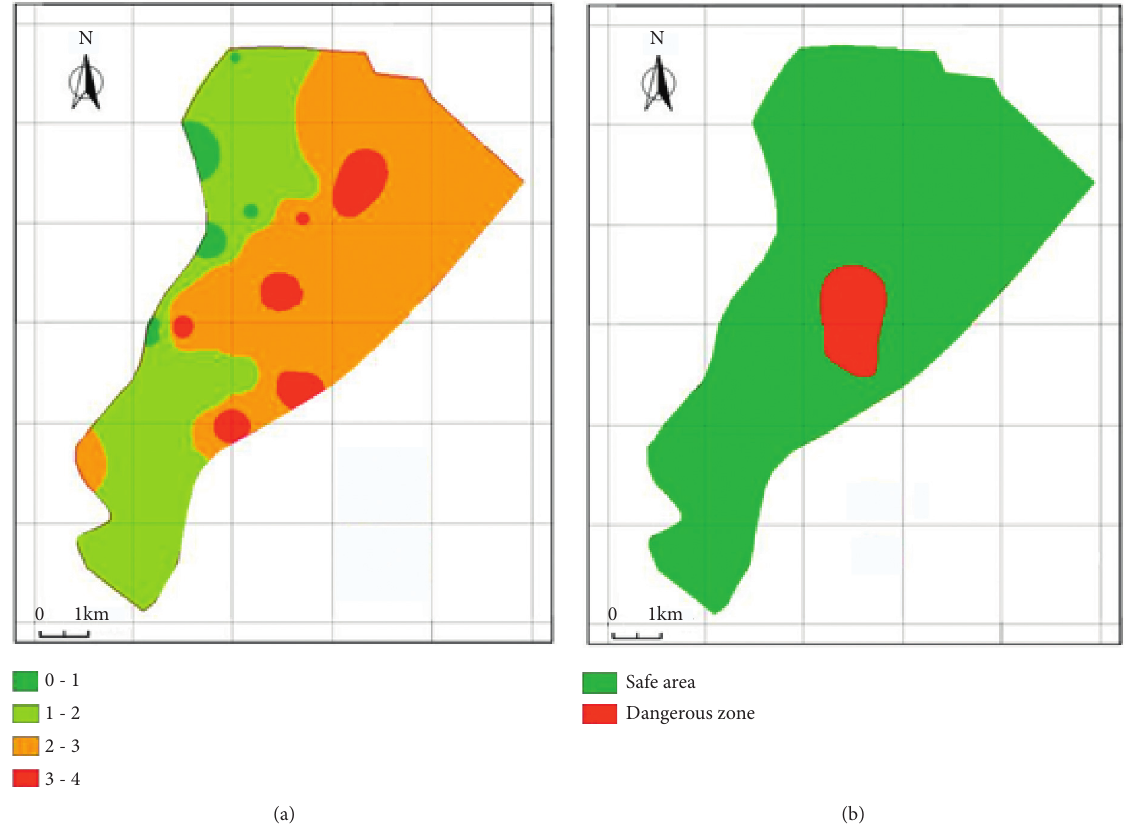
Figure 3: The zoning maps of water inrush risk. (a) By the VWUM model. (b) By the WIC